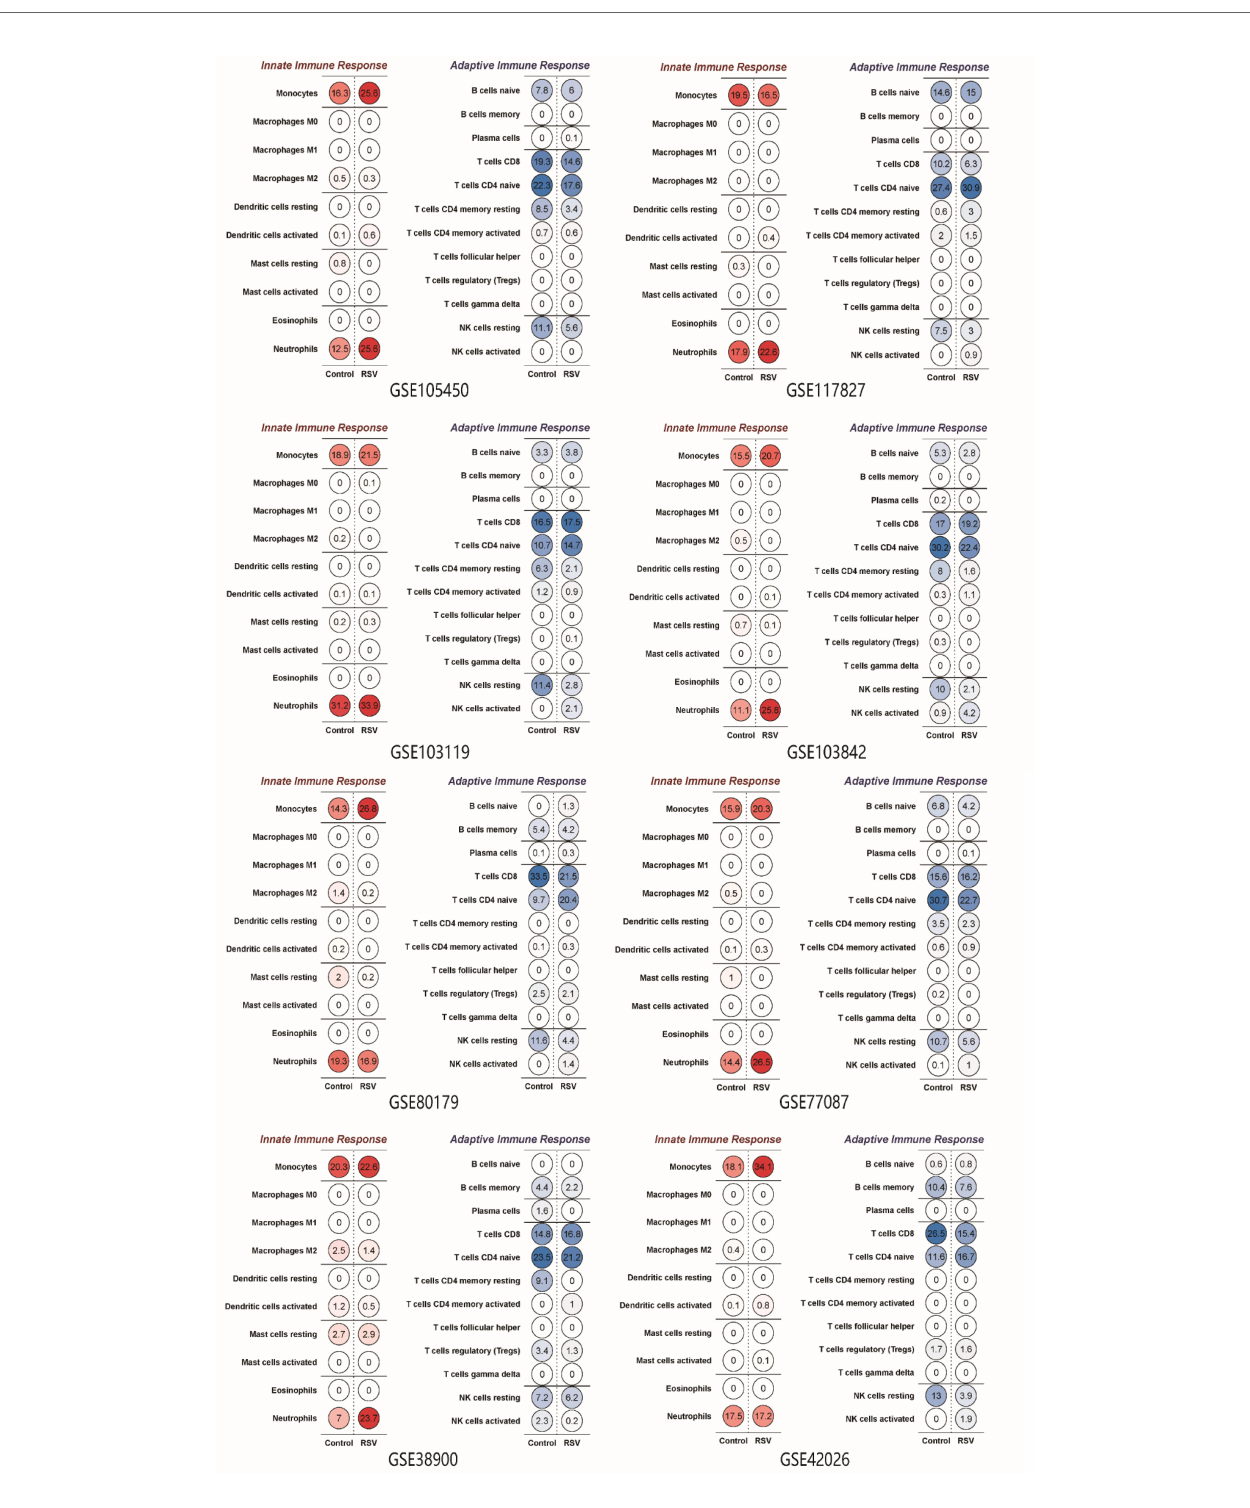
FIGURE 5 | The proportion of immune cell types in different datasets. Note that the proportion of neutrophils in most datasets was higher in the RSV-infected groups than in the healthy groups.